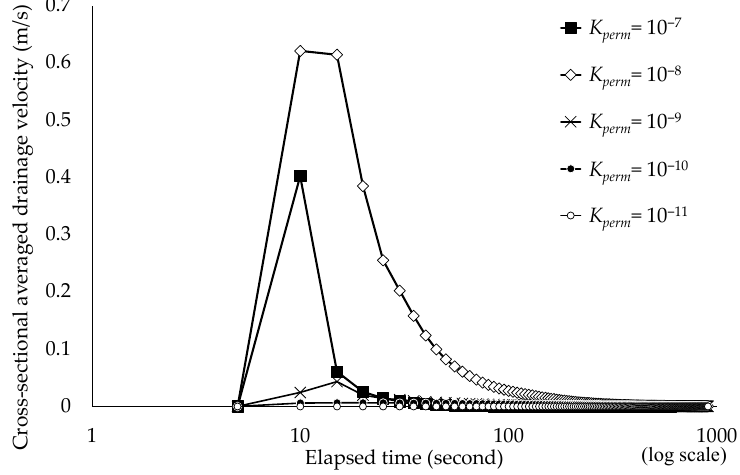
Figure 6. Determination of permeability coefficient from the numerical test [28].